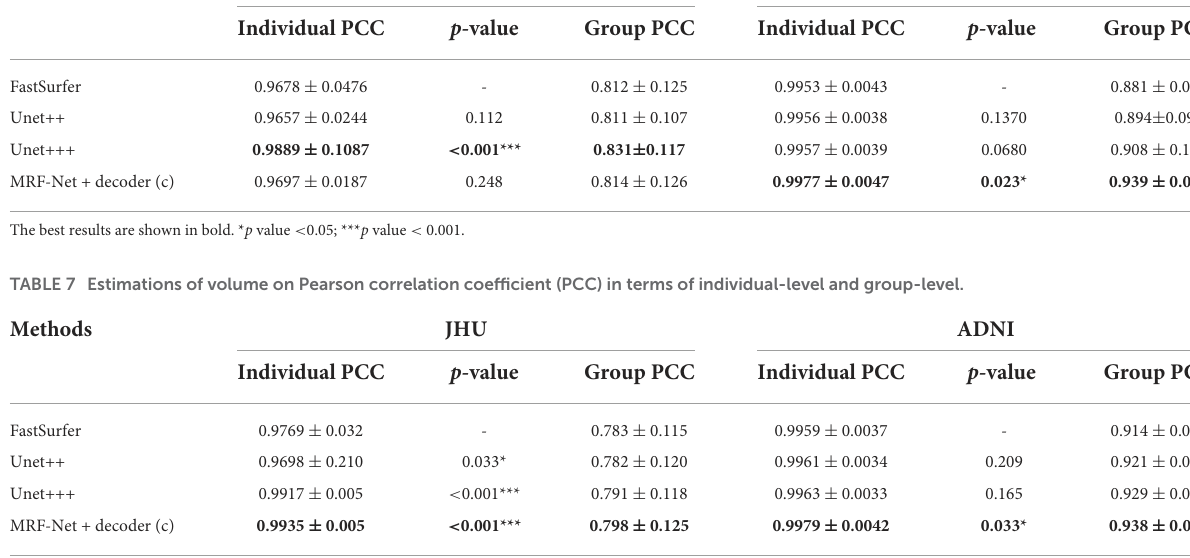
study that compared with MRF-Net +decoder (a) (w/o